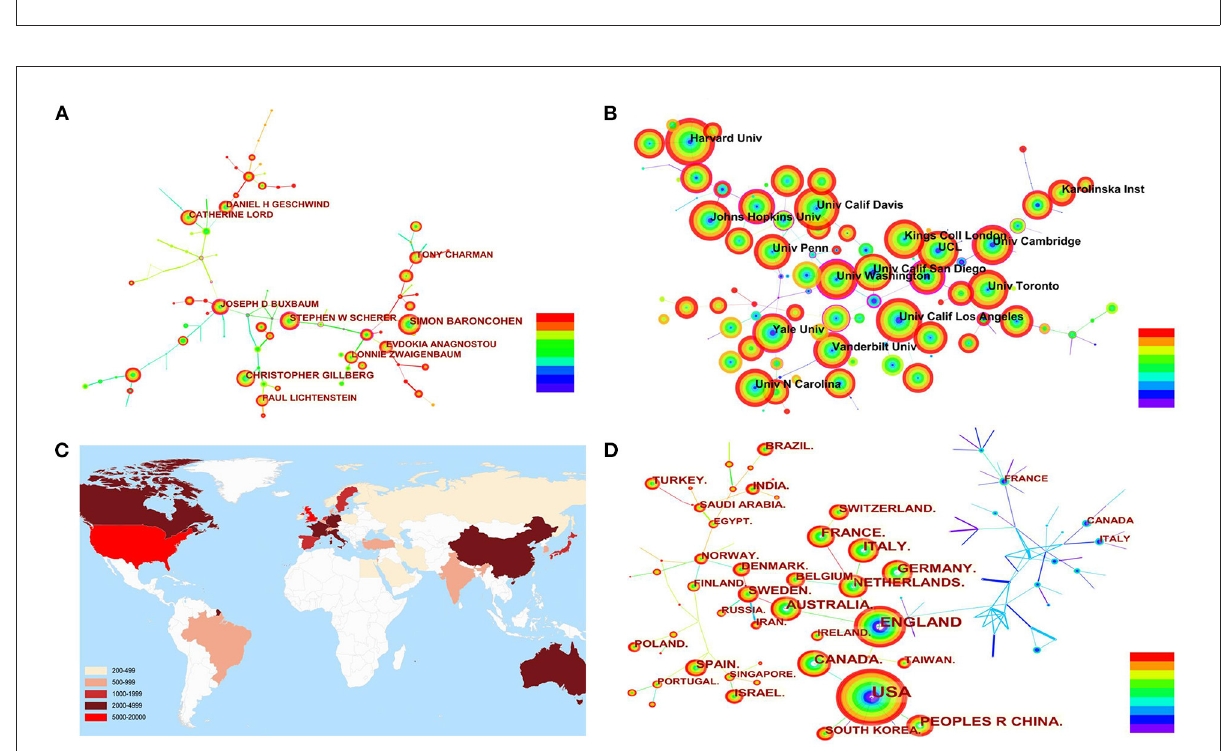
FIGURE2 Publication of ASD related papers from 1998 to